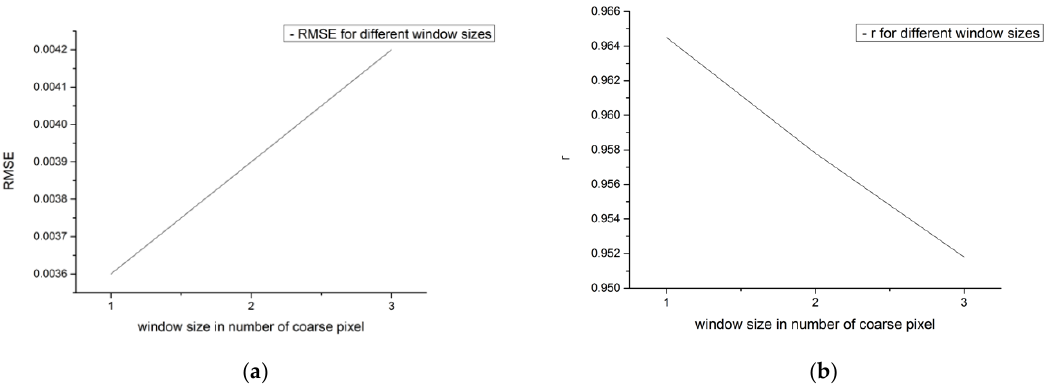
Figure 12. The ( a ) RMSE and ( b ) r of the fusion results with applying different window sizes (from 1 coarse pixel to 3 coarse pixels) in the HNN-SPOT algorithm.